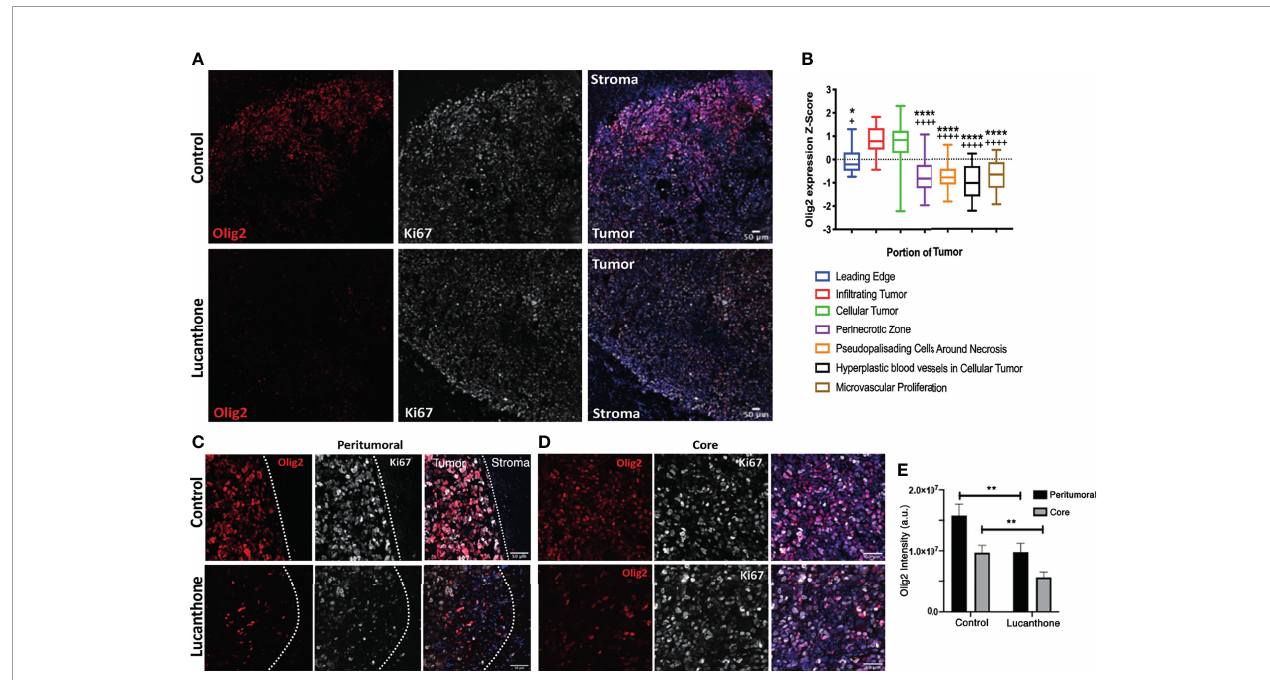
FIGURE 6 | Lucanthone reduced Olig2 + positivity in tumors in vivo . (A) Representative immunohistochemical images of Olig2 and Ki67 in tumors and surrounding stroma in saline- and lucanthone-treated mice. (B) Expression of Olig2 in different areas in human glioblastomas adapted from the Ivy Glioblastoma Atlas. ****p < 0.0001 Kruskal-Wallis test, demonstrating signi fi cant differences in Olig2 expression among various tumor areas. *p < 0.05, ****p < 0.0001 Dunn ’ s test, compared to in fi ltrating tumor. + p < 0.05, ++++ p < 0.0001, Dunn ’ s test, compared to cellular tumor. (C, D) Olig2 expression in tumor periphery and tumor core in both treatment conditions with intensity quanti fi cations in (E) Two-way ANOVA p < 0.05. **p < 0.01, Bonferroni multiple comparison test. Bars are mean +/- SEM, N=4 animals per